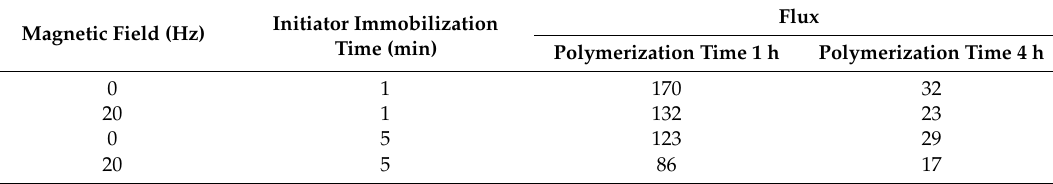
Table 3. Pseudo-steady-state flux (L m − 2 h − 1 ) during 1 mg / mL of bovine serum albumin (BSA) filtration. Magnetic Field (Hz)